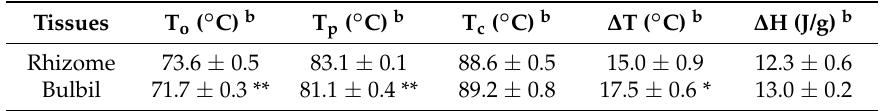
Table 4. Thermal parameters of starches a .